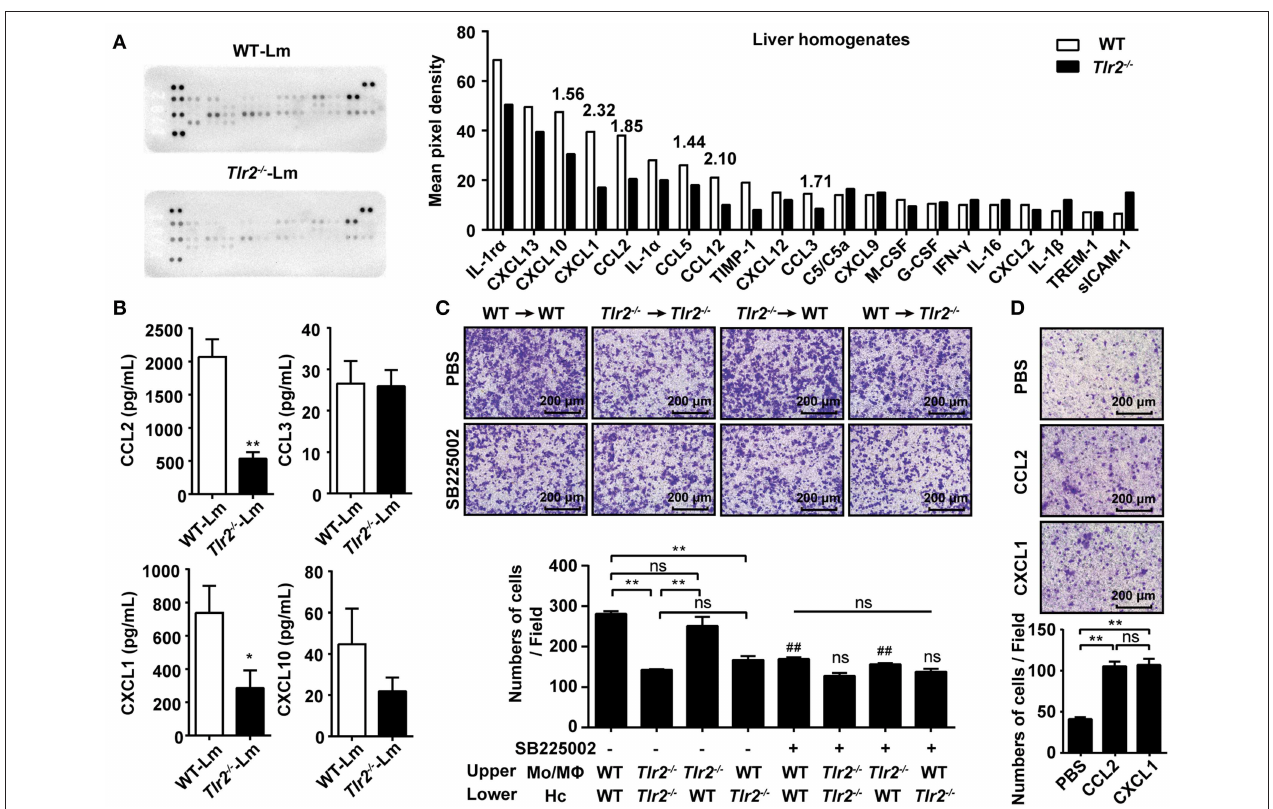
FIGURE 2 | TLR2 promotes the production of chemokine released by hepatocytes in response to Lm-infection. (A) WT and Tlr2 − / − mice were i.p. infected with 1 × 10 6 CFU of Lm for 2 days. The expression of cytokines/chemokines in the liver homogenates (pooled samples from five mice per group) was measured using a proteome profiler array. (B) Hepatocytes were isolated from WT and Tlr2 − / − mice and infected with Lm (MOI = 20:1) in vitro . Chemokine production was measured by an ELISA at 12h post infection ( n ≥ 5). (C) Hepatocytes from WT or Tlr2 − / − mice were seeded into the lower chamber and infected with Lm for 12h. The Mo/M 8 s were added to the inserts with or without the CXCR2 antagonist, SB225002. Photographs were taken after 4h of migration (one representative of three independent experiments). #, SB225002-treated groups vs. untreated groups. (D) Mo/M 8 recruitment by CCL2 and CXCL1 was measured using a transwell chamber migration assay (one representative of three independent experiments). Data are presented as the mean ± SEM. * p < 0.05, **, ## p <